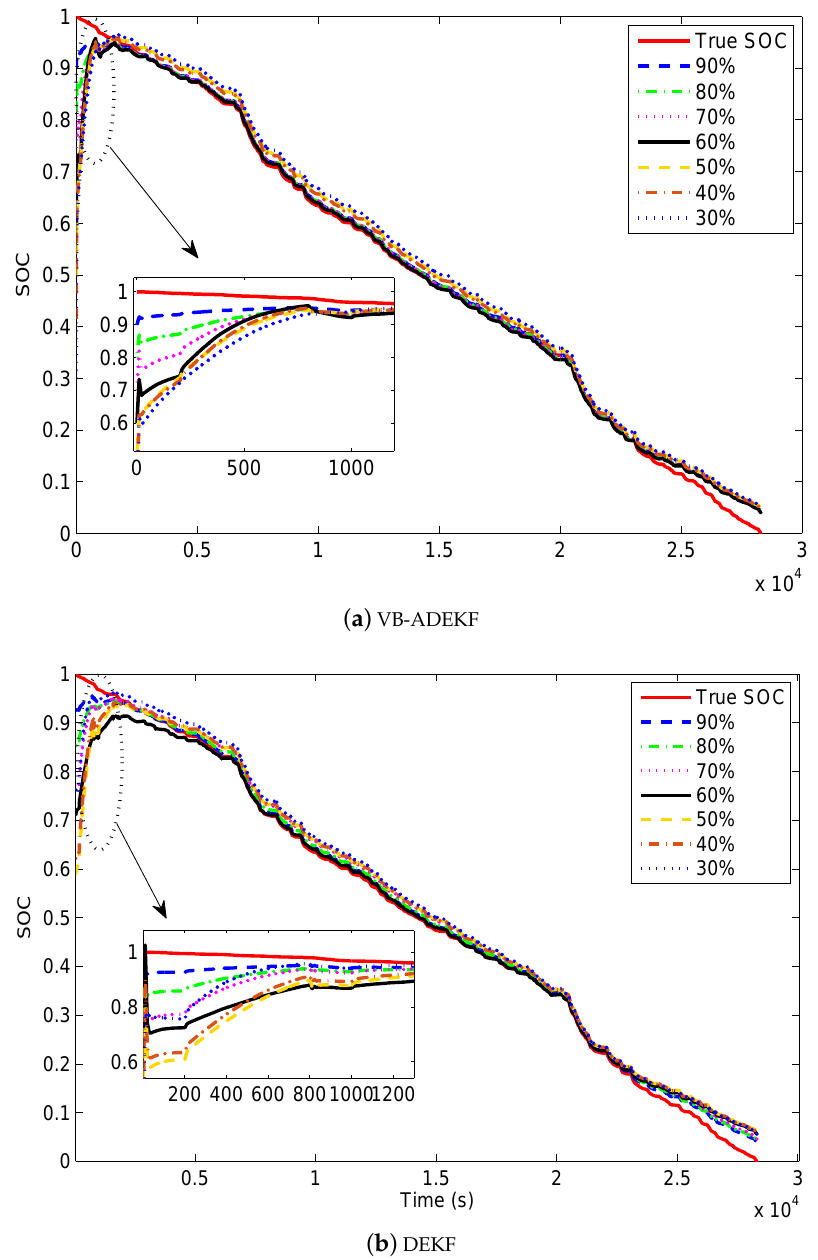
Figure 16. SOC estimation results of the two filters with different initial SOC values in the UDDS